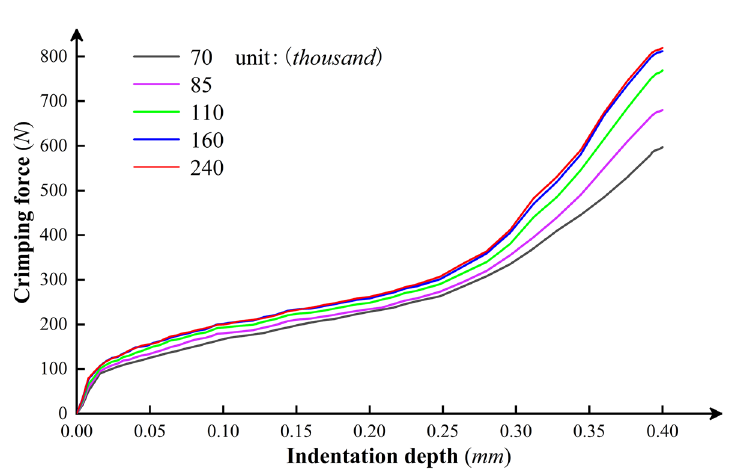
Figure 8. Crimping force curve as a function of the indentation depth under different numbers of mesh